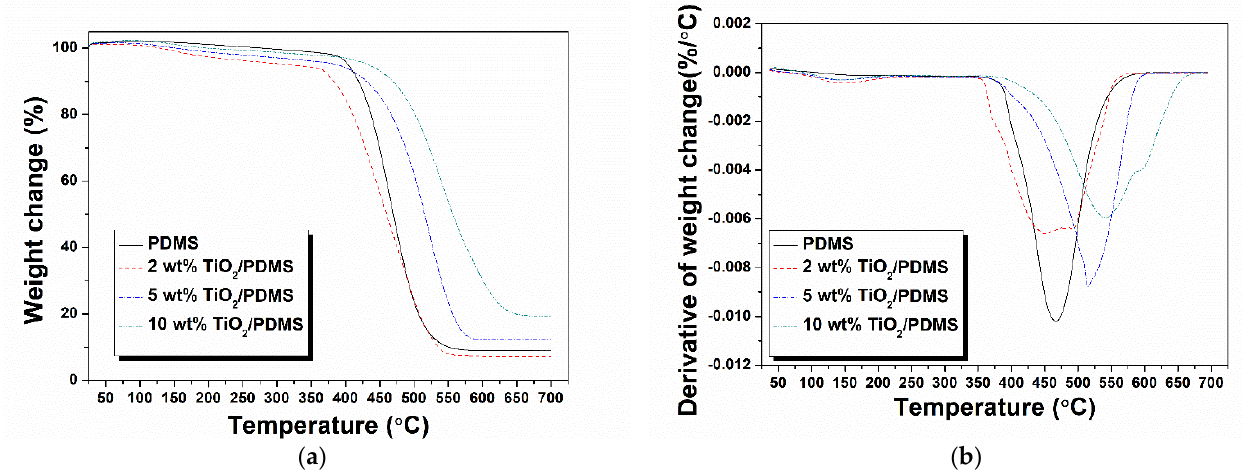
Figure 3. TGA curves of PDMS and TiO 2 /PDMS nanocomposites: ( a ) weight change; and ( b ) derivative of weight change, versus temperature. Table 2. TGA results of PDMS and TiO 2 /PDMS nanocomposites.